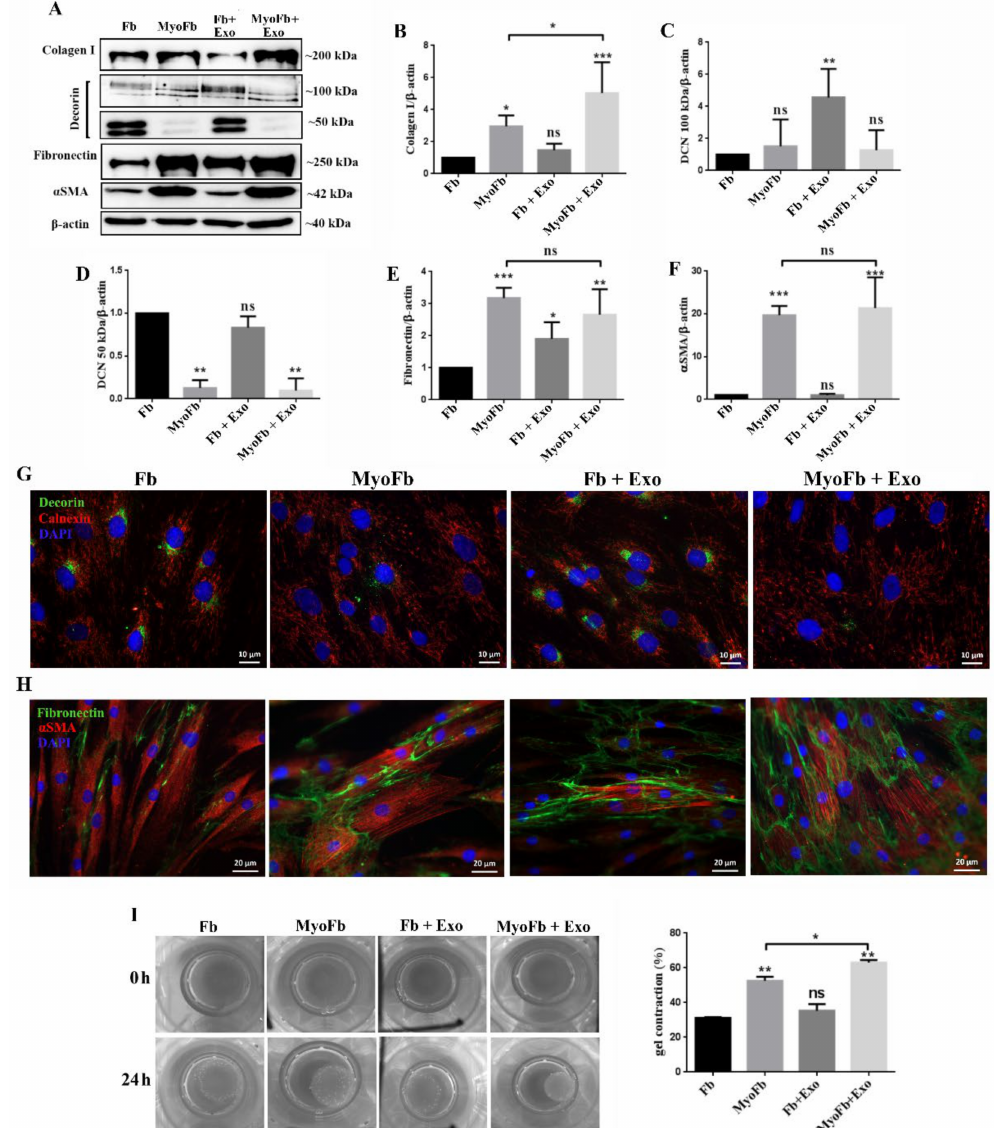
Figure 7. Exosomes stimulate the expression of proteins involved in matrix remodeling and contrac- tion in fibroblasts differentiated towards myofibroblasts. ( A ) Representative Western blots images and quantification relative to β -actin for type I collagen ( B ), decorin ( C , D ), fibronectin ( E ), and α SMA ( F ). ( G ) Immunocytochemistry image indicating the changes of decorin in fibroblasts treated with TGF β 1, exosomes, TGF β 1 and exosomes, and its distribution in relation to the endoplasmic reticulum evidenced by calnexin. ( H ) Fluorescence microscopy image showing the organization of α SMA in stress fibers in TGF β 1-treated samples and the extracellular organization of fibronectin. ( I ) Gel contraction assay demonstrating the contractile activity of fibroblasts as such (control), differen- tiated (TGF β 1), incubated with exosomes (Exo), and simultaneously stimulated with TGF β 1 and exosomes (TGF β 1 + Exo). The results are given as the percentage of the initial area of the gel. Data are means ± SD ( n = 3), * p < 0.05; ** p < 0.01, *** p < 0.001, ns—not